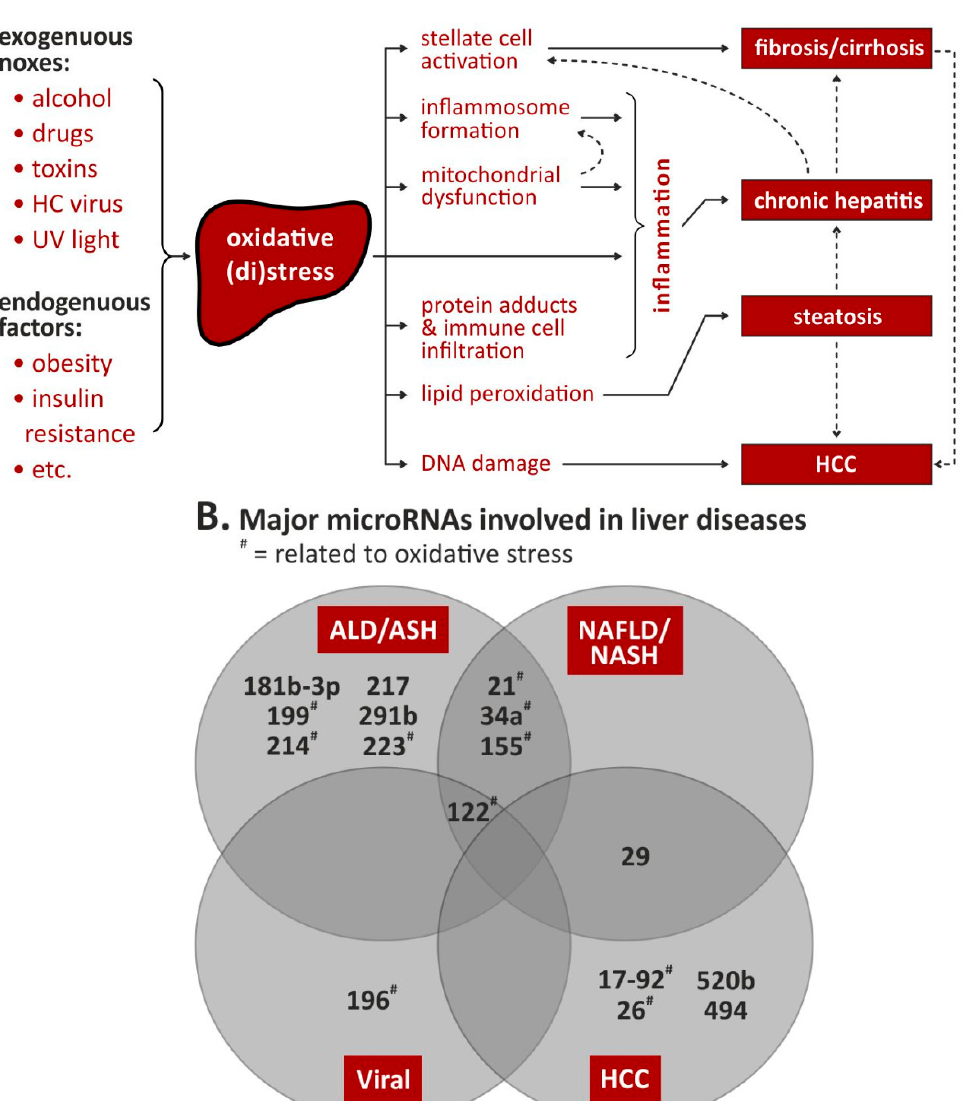
Figure 2. Oxidative stress- and microRNA-dependent liver pathogenesis. ( A ). Possible effects of oxidative stress and subsequent liver diseases; modified from [31]. ( B ). Venn diagram on known involvement of microRNAs in the four liver pathologies; for details, see text and Tables 2–5. Abbreviations: ALD = alcoholic liver disease, ASH = alcoholic steatohepatitis, HCC = hepatocellular carcinoma, NAFLD = nonalcoholic fatty liver disease, NASH = nonalcoholic steatohepatitis, # = related to oxidative